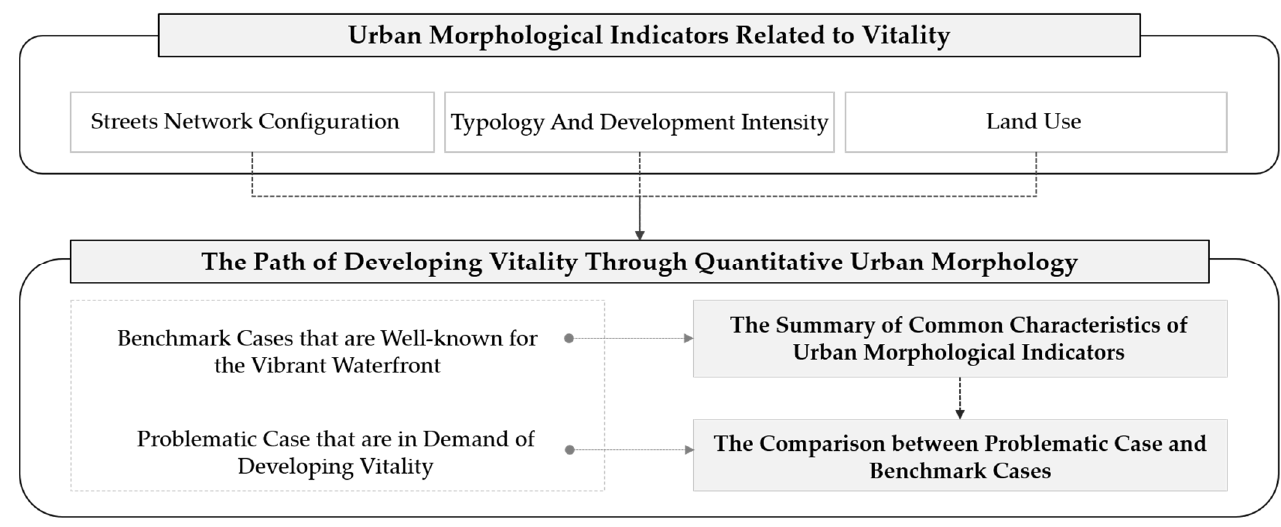
Figure 1. The analytical framework.